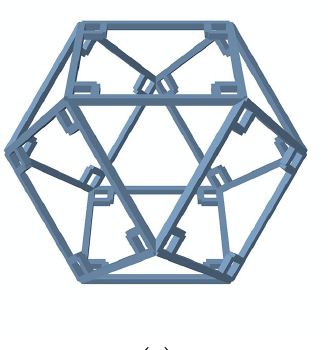
Figure 3. Three types of fundamental cells: ( a ) Rigid cell; ( b ) Compliant cell; and ( c ) Auxetic cell. To quantitatively understand its deforming mechanism and verify the aforemen- tioned conclusions, the stiffness and Poisson’s ratio of the three types of fundamental cells are analyzed through a parametric finite element analysis. The analysis result can further provide some guidance for the selection of the specific geometric parameters of each type of cell. In engineering, the Euler–Bernoulli beam theory is relatively commonly utilized [36] and is quite suitable for the compliant and auxetic cells featured with bending defor- mation. In the lattice structure, the cell edges connected between vertexes are simplified